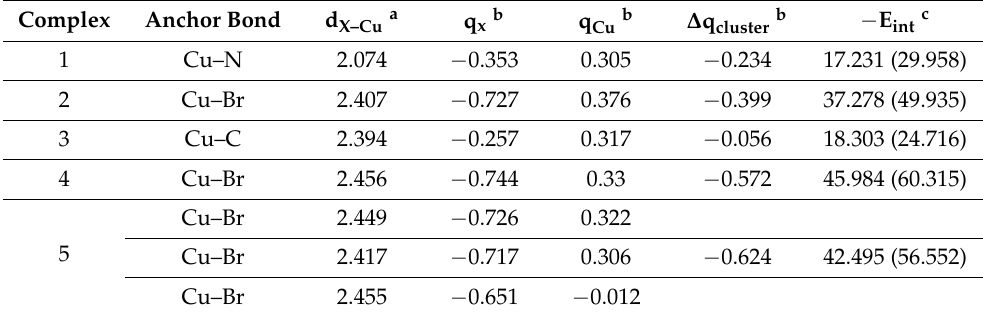
Table 1. Theoretical parameters calculated to establish the potential coordination sites between CuNPs and